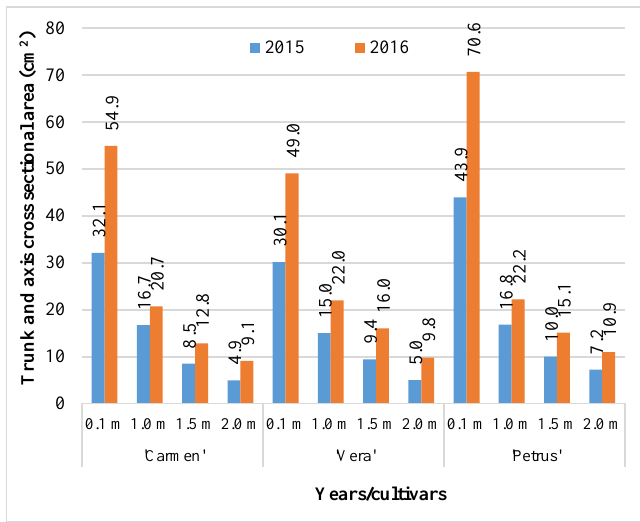
Figure 2. Trunk and central axis cross sectional area at slender spindle canopy (Debrecen-Pallag, 2015-2016) From the bottom to the top natural slimming can be noticed, but its scale is different for each cultivar, which describe well their characteristics. Cultivar ‘Carmen’ and ‘Vera’ showed bottom parts. Cultivar ‘Vera’ has the thinnest trunk measured 10 cm high from the ground in both years (30.1 and 49.0 cm 2 ), while these values are more equalized to the top. At the same time axis thickness of cv. ‘Vera’ is above the values of cv.